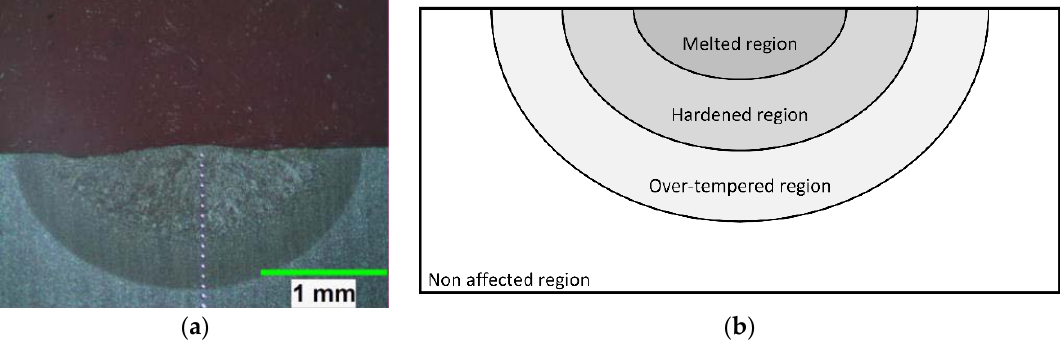
Figure 1. Metallographic cross-section of the hardened region ( a ) and representation of a typical cross-section of a laser-hardened plate ( b ).